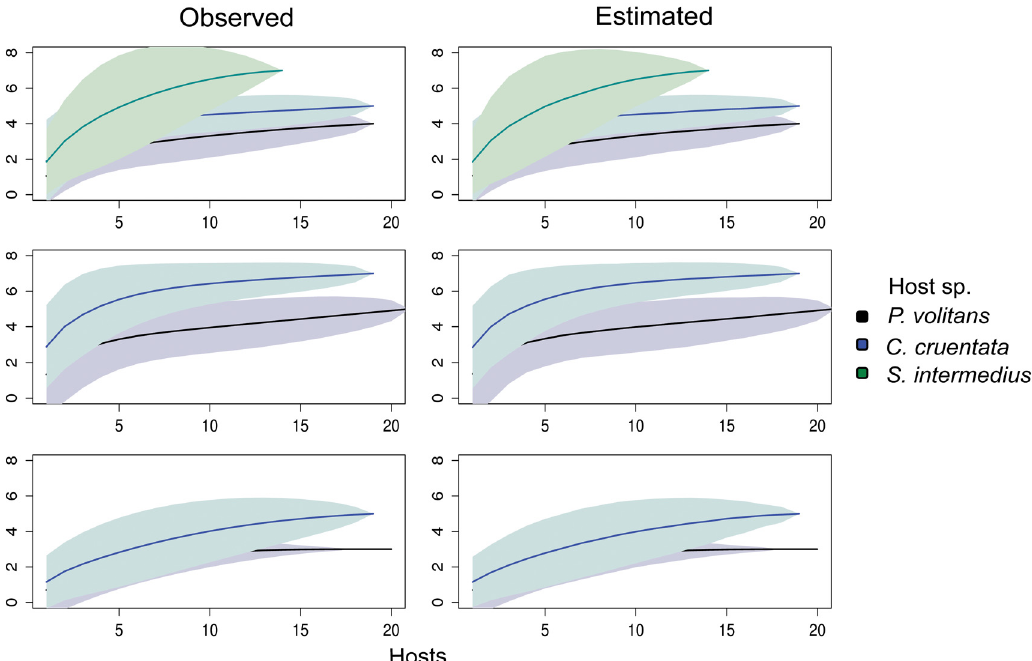
Fig 6. Parasite species accumulation curves for lionfish and native hosts collected in three sites in Panama. The species accumulation curves based on observed and expected richness for Cristobal are shown in (A) and (B), respectively, for Portobelo in (C) and (D), and for Hospital Point in (E) and (F). Each host species is represented by a specific color: P . volitans (black), C . cruentata (blue), and S . intermedius (green). Note that S . intermedius was collected only in Cristobal and is therefore absent from the other